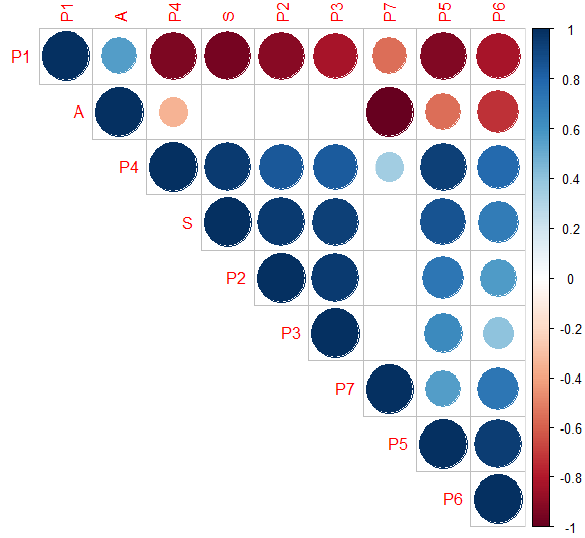
Figure 3. The probability results of each state for Case 1 : k = 0.005, v = 0.001, and w = 0.0007.